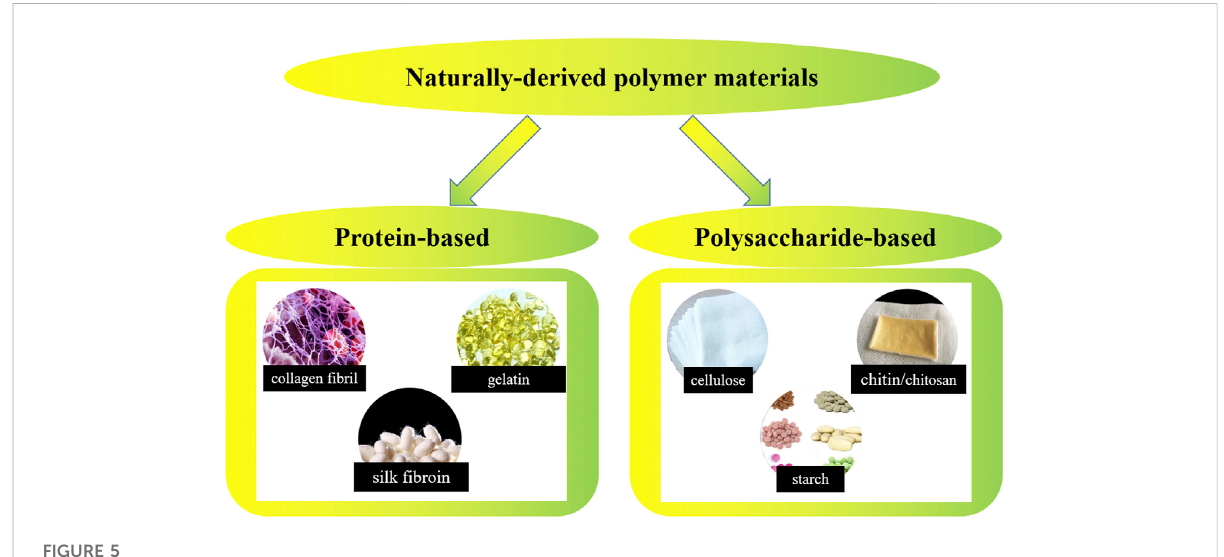
FIGURE 5 Typical classi fi cation of naturally-derived polymer